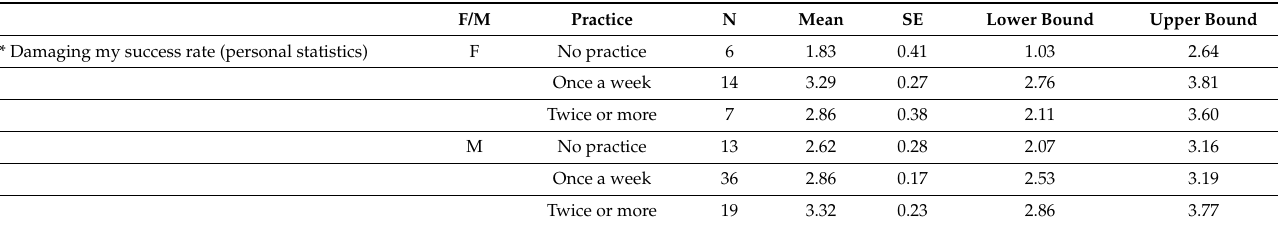
Table A2. Responses to nine anxiety items by gender and amount of